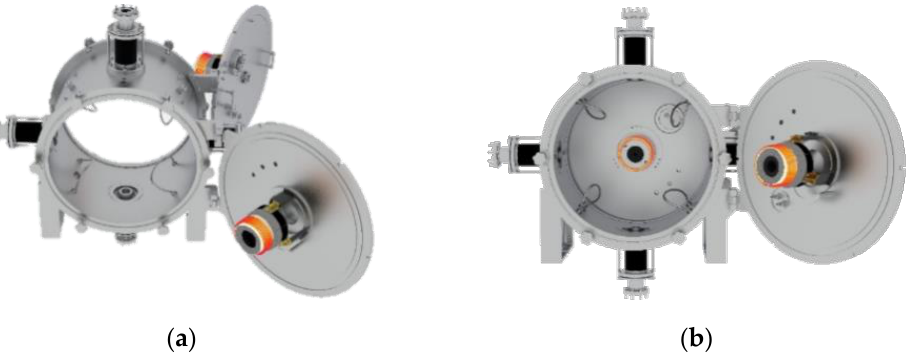
Figure 7. High-temperature cavity design model. ( a ) Double test door opening; ( b ) main heating side door opening.